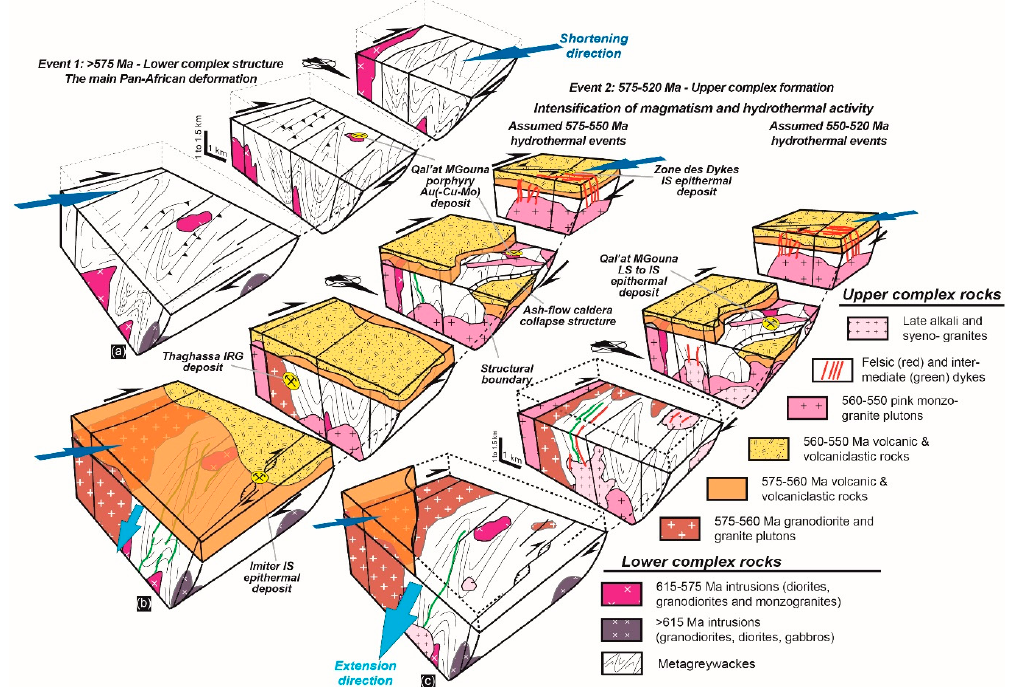
Figure 12. Interpretative three ‐ phase model ( a–c ) explaining the tectono ‐ magmatic evolution as well as the Lower and Upper Complexes definition of the Jbel Saghro and the formation of the ore ‐ bearing vein systems of the Zone des Dykes, Qal’at MGouna, Thaghassa and Imiter districts. The size of the blue arrow relates with the inferred intensity of regional stress. See text for explanation. Note that the Qal’at MGouna porphyry deposit may belong to either the late stage of event 1 or the earlier stage of event 2 as the related porphyry stock emplaced at the transition between the two at 576 ± 5 Ma [29]. Previous interpretations tried to link each type of structures or pluton emplacement to one distinct tectonic event, increasing the complexity. From this study, it appears more appropriate to interpret all these features by the occurrence of a single and unique D 1 tectono ‐ magmatic event. According to Gasquet et al. [83], as basins infilling with greywacke sequences was active until the